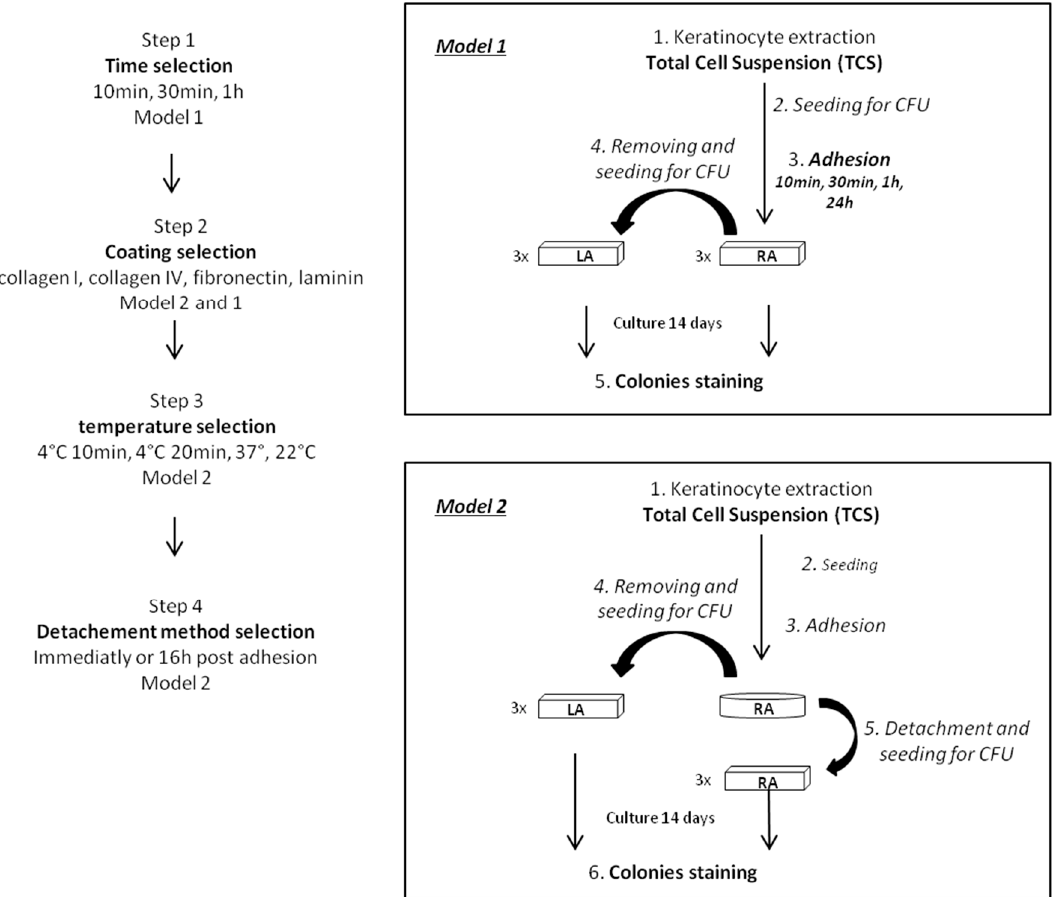
Figure 1. Schematic representation of experimental protocol of rapid adhesion method optimization using model 1 or model 2 according to the step. Arrows correspond to chronological steps.